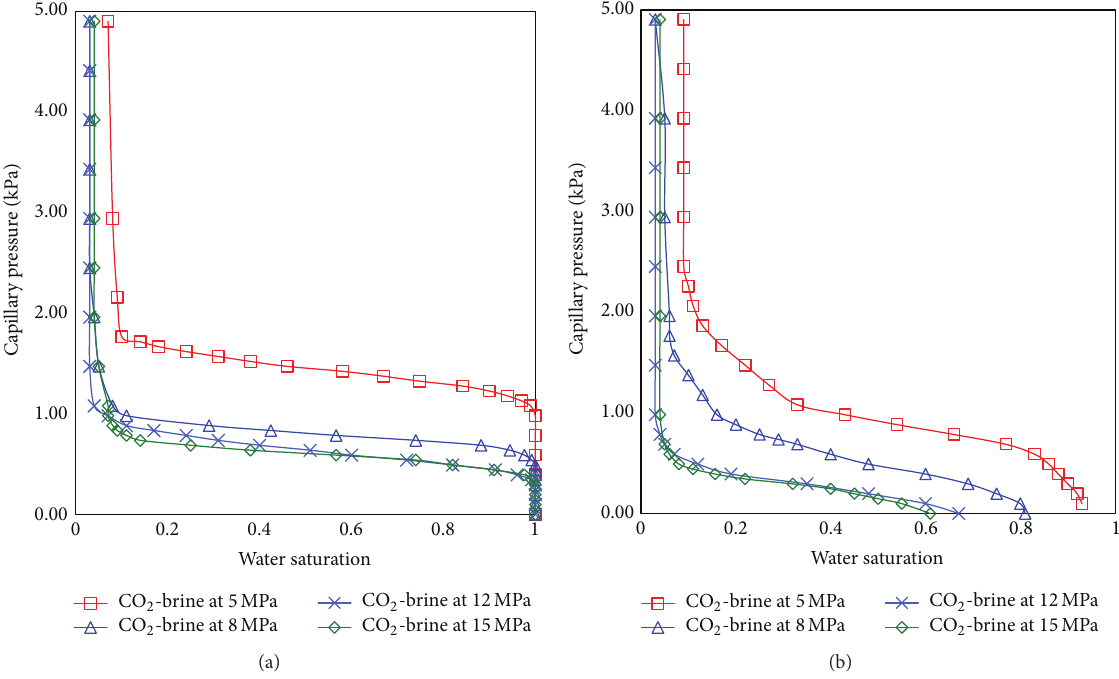
Figure 4: Capillary pressure-water saturation curve of CO 2 -brine at 3 M NaCl. (a) Drainage and (b) imbibition.